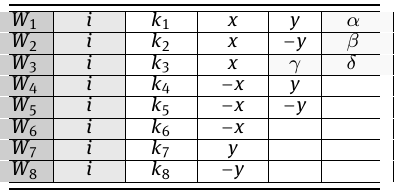
Table 3. Partial index distribution of the codewords of G i .